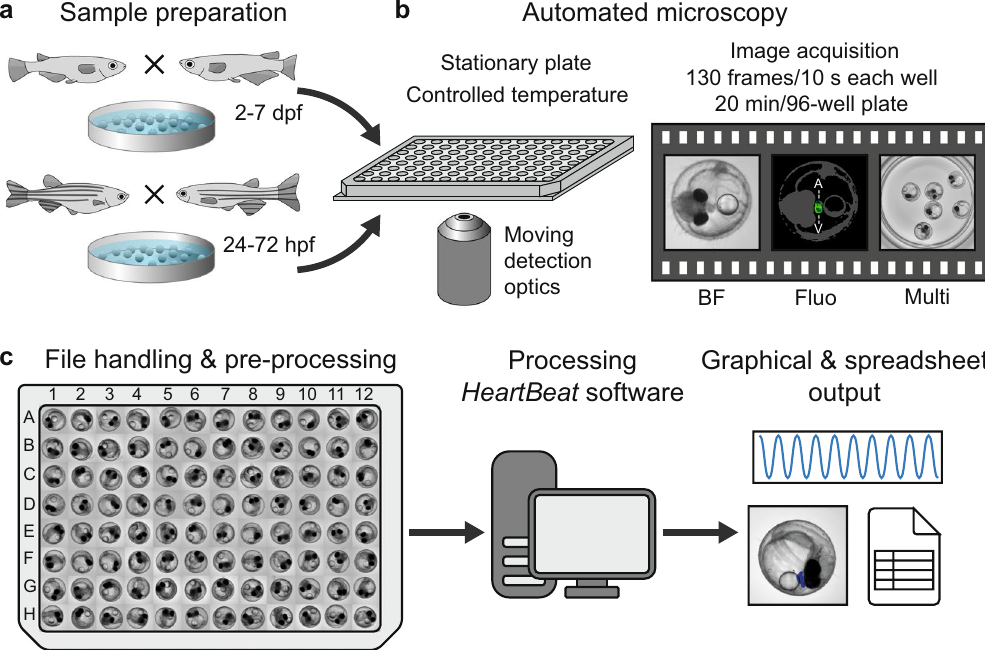
Figure 1. Workflow of automated imaging and heart rate quantification in medaka and zebrafish embryos. ( a ) Cardiovascular development is functional after 24 and 48 hpf and hatching occurs around 48–72 hpf and 7–8 dpf in zebrafish and medaka, accordingly, defining time windows of embryonic cardiac imaging in both fish species. ( b ) Single or multiple fish embryos per well are mounted without anaesthesia or agarose into microtiter plates, which have a fixed position in the imaging platform; image sequences can be sampled at different frame rates, resolutions and channels; all images were recorded with 2x objective, images with single embryos were cropped, multiple embryos in a well (Multi) are presented as full frame; in the fluorescent image A and V denote atrium and ventricle and a rough outline of the embryo is overlaid as a reference. ( c ) After image optimization, image sequences are quantified through a GUI of the HeartBeat program (compare Fig. 2) and heart rates, beat- to-beat variability and an overview of segmentation are saved as spreadsheet and graphical output,